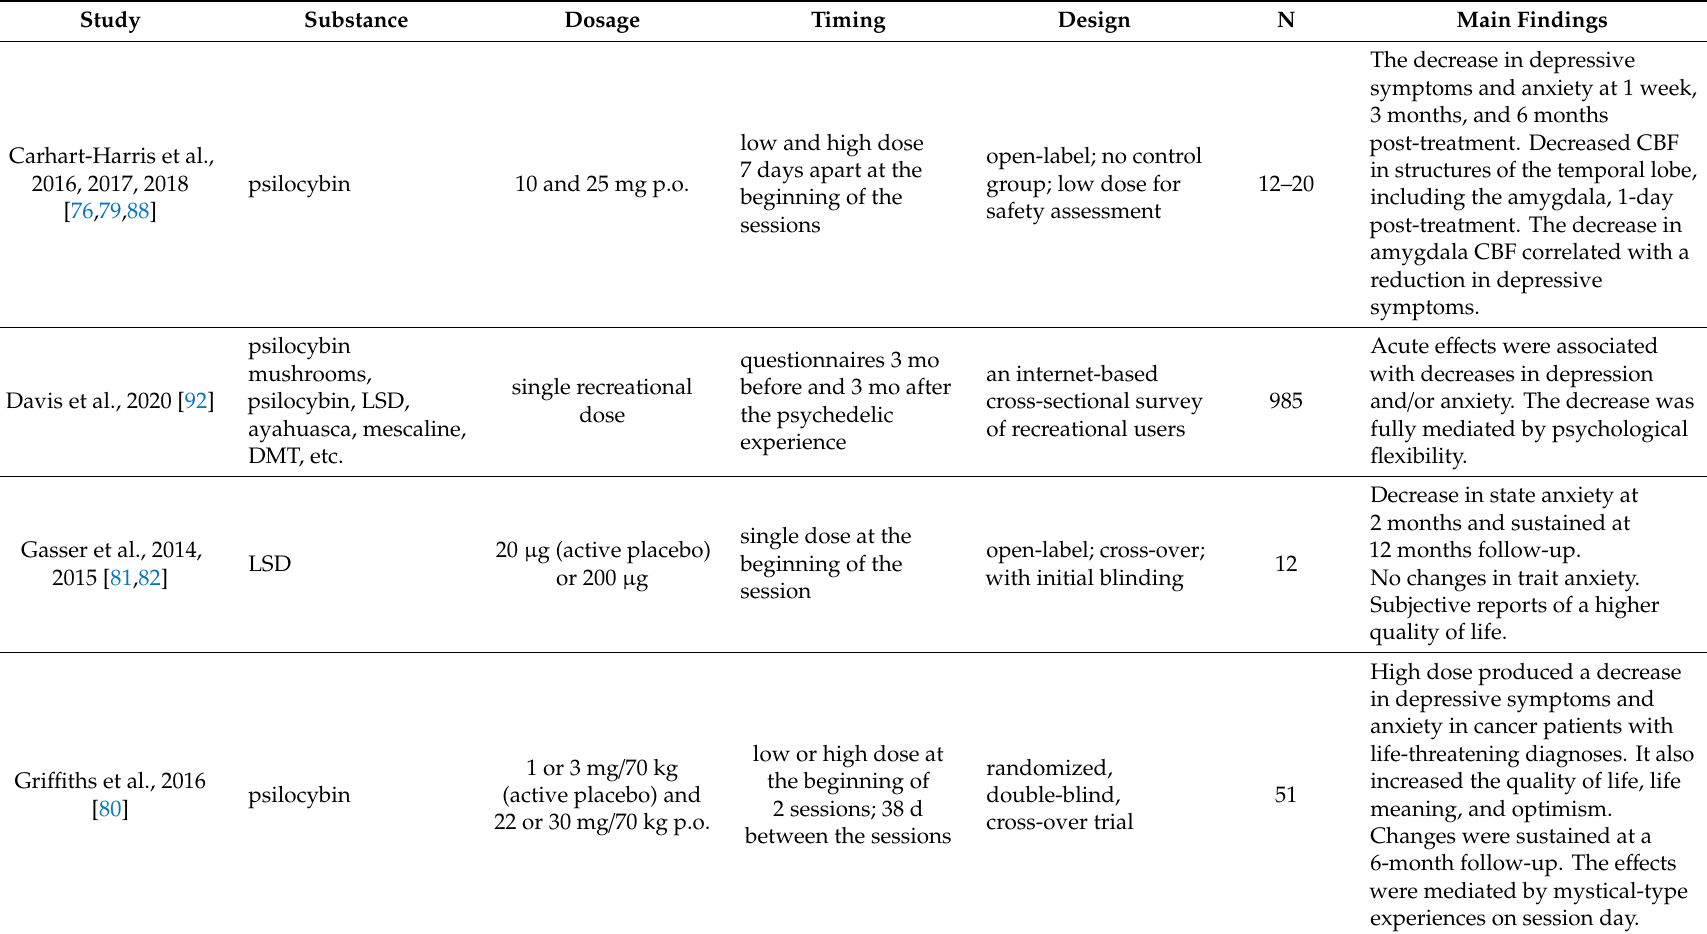
Table 2. Key human studies on the clinical e ff ects of